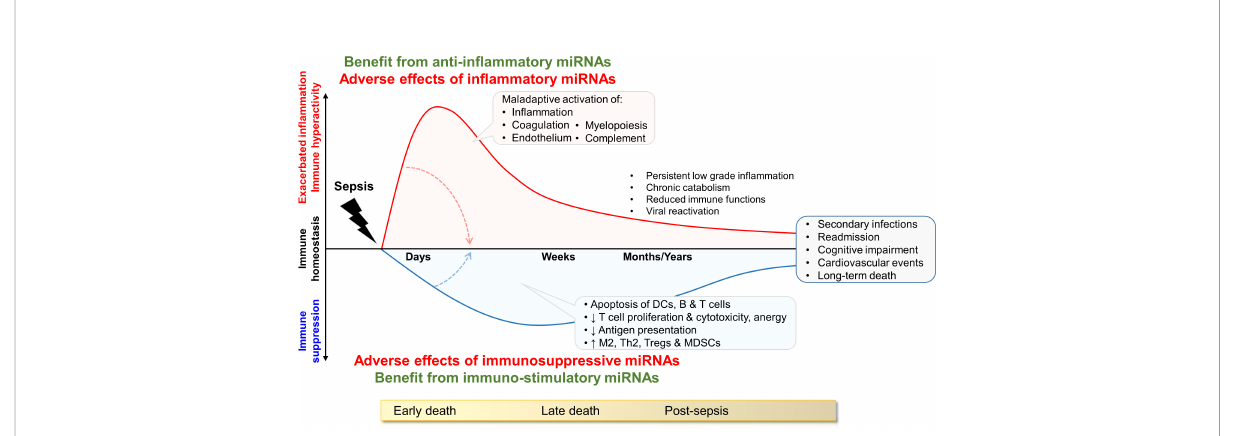
FIGURE 1 Model of immune status during sepsis and potential impact of miRNAs. The drawing shows the dysregulation of immune homeostasis over time, and lists pathophysiological consequences. The in fl ammatory and immunosuppressive responses are represented concurrently. Early deaths